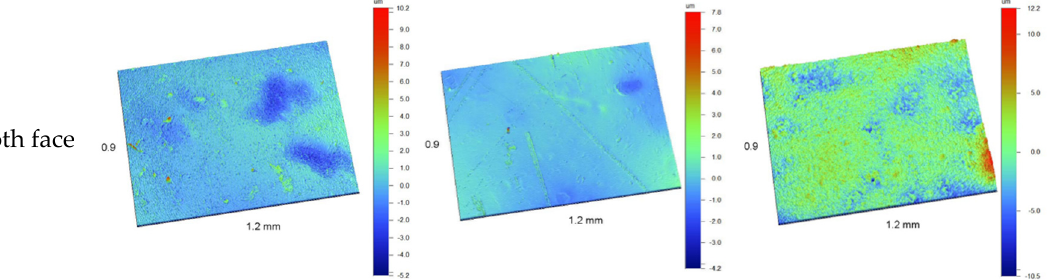
Figure 9. 3D imaging with the topographic enhancement of the rough face and smooth face.